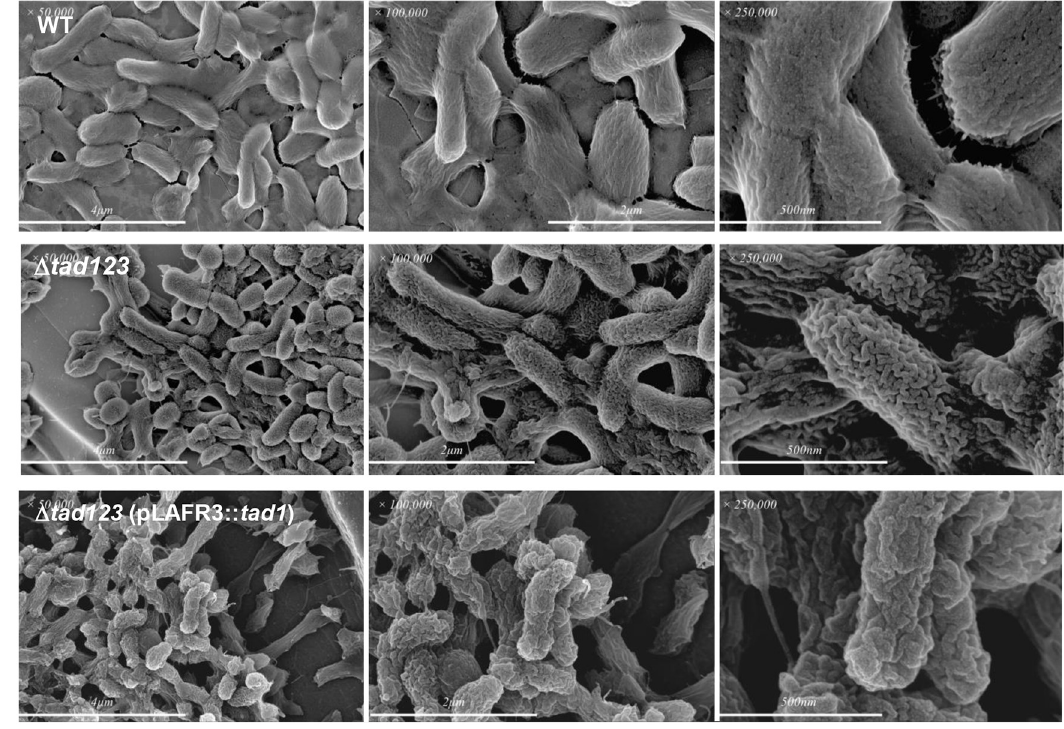
Fig 3. Ultrastructural observation of V . vulnificus . Bacteria were grown in vivo using a rat peritoneal infection model. The specimens were examined by SEM.